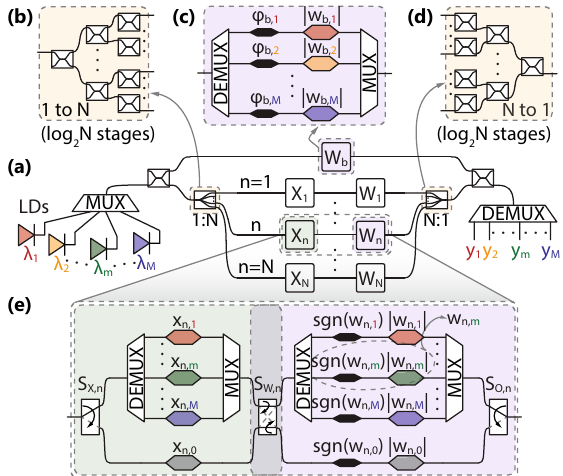
Figure 1. ( a ) Schematic representation of PPNN showing M laser diodes (LDs), a MUX, a 3dB X-splitter followed by a bias branch ( W b ) and a reconfigurable OLAU encompassing 1-to- N splitting stage, input ( X n ) and weight ( W n ) modulator banks and an N -to-1 combiner stage, the output of which is brought to interfere with the bias signal within 3dB X-coupler and sent to the DEMUX. Closer look into ( b ) 1-to- N splitting and ( d ) its π -rotated N -to-1 coupling stage. Zoom-in into the ( c ) bias branch wavelength selective weights and phase modulators and ( e ) an axon of the OLAU consisting of switches for signal routing and modulators for inputs ( x n , m ) and weights ( w n , m